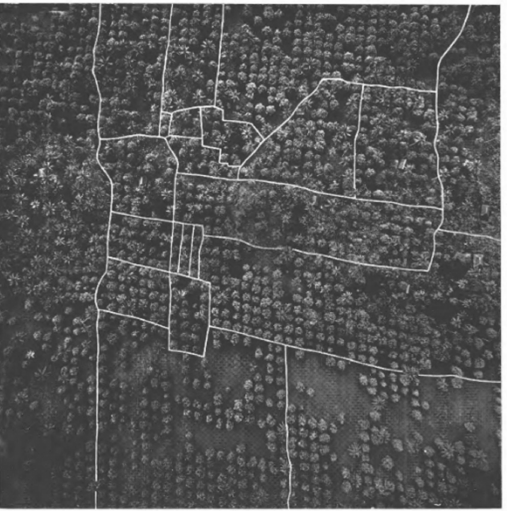
Figure 5. Long before GIS, overlay of cadastral boundaries using photographic techniques was trialled and applied, including in Africa (adapted from